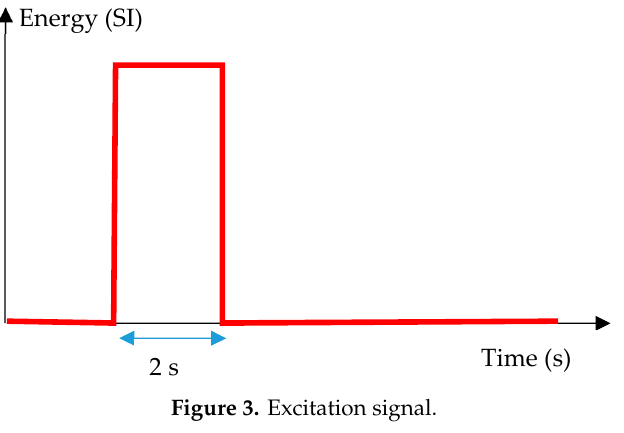
Figure 3. Excitation signal.